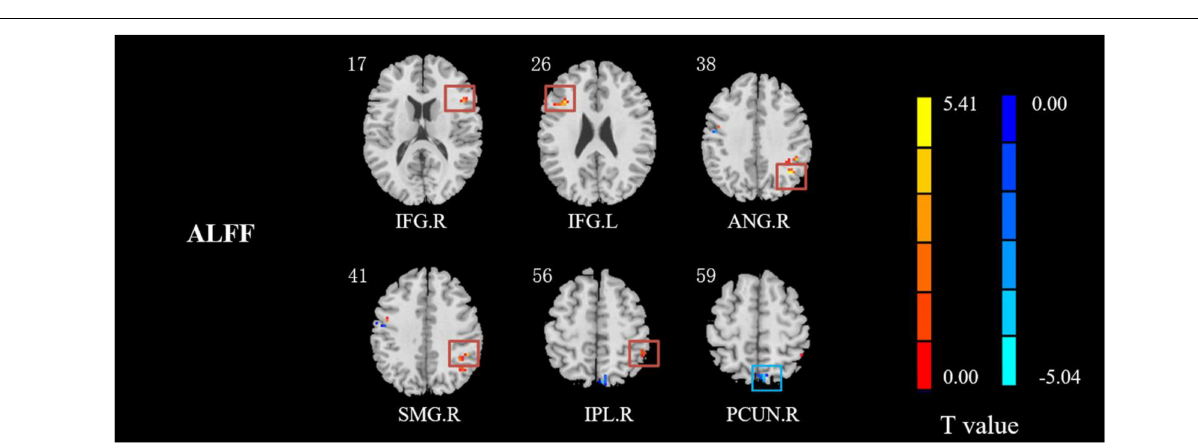
FIGURE 2 | The different ALFF regions between IXT patients and HCs. ALFF values in IXT patients increased in the right ANG, SMG, IPL, and the bilateral IFG, and decreased in the right PCUN. (GRF corrected, P < 0.05.) ANG: angular gyrus; SMG: supramarginal gyrus; IPL: inferior parietal lobule; IFG: inferior frontal gyrus; PCUN: